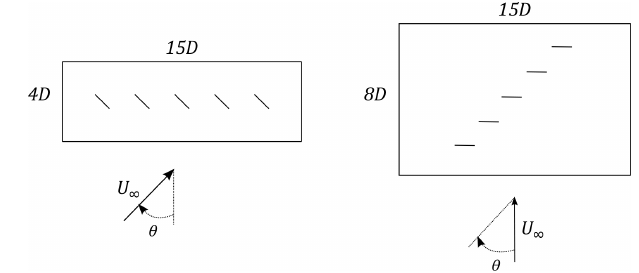
Figure 2. Standard and staggered configurations with boundaries of the refined